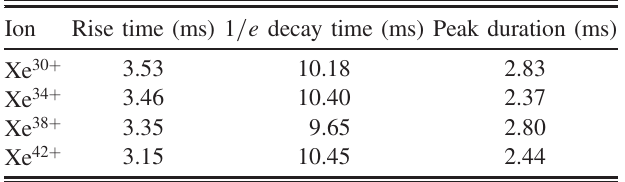
TABLE IV. Waveform parameters of optimum xenon afterglow